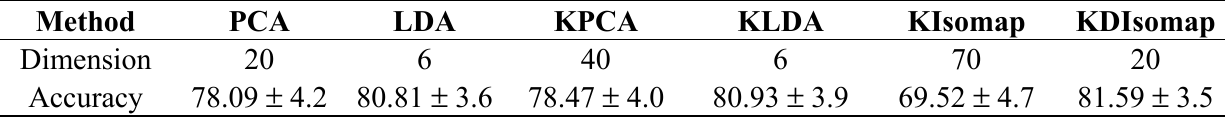
Table 1. The best accuracy (%) of different methods on the JAFFE